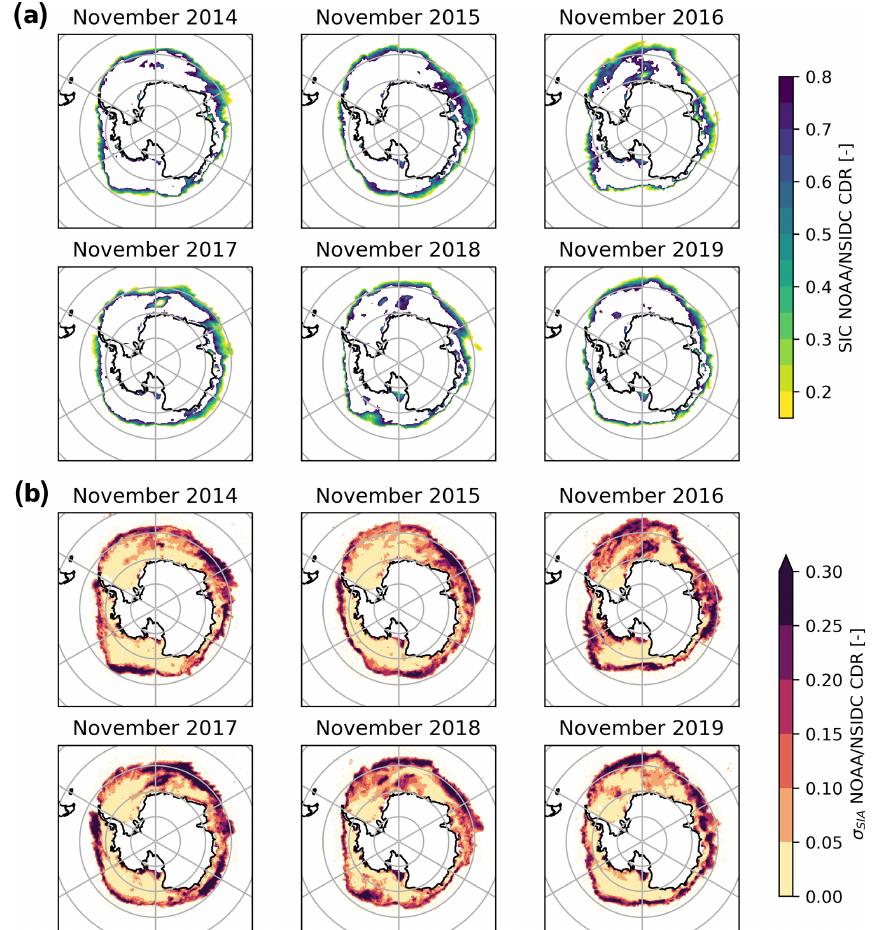
Figure 7. November maps of (a) the mean SIC for the standard MIZ thresholds (0 . 15 ≤ SIC < 0 . 80) and (b) the σ SIA indicator from the NOAA/NSIDC CDR for the years 2014–2019. Note the scale change with respect to Fig. 4. Years from 2008 to 2019 are shown in Figs. S5 and S6 in the